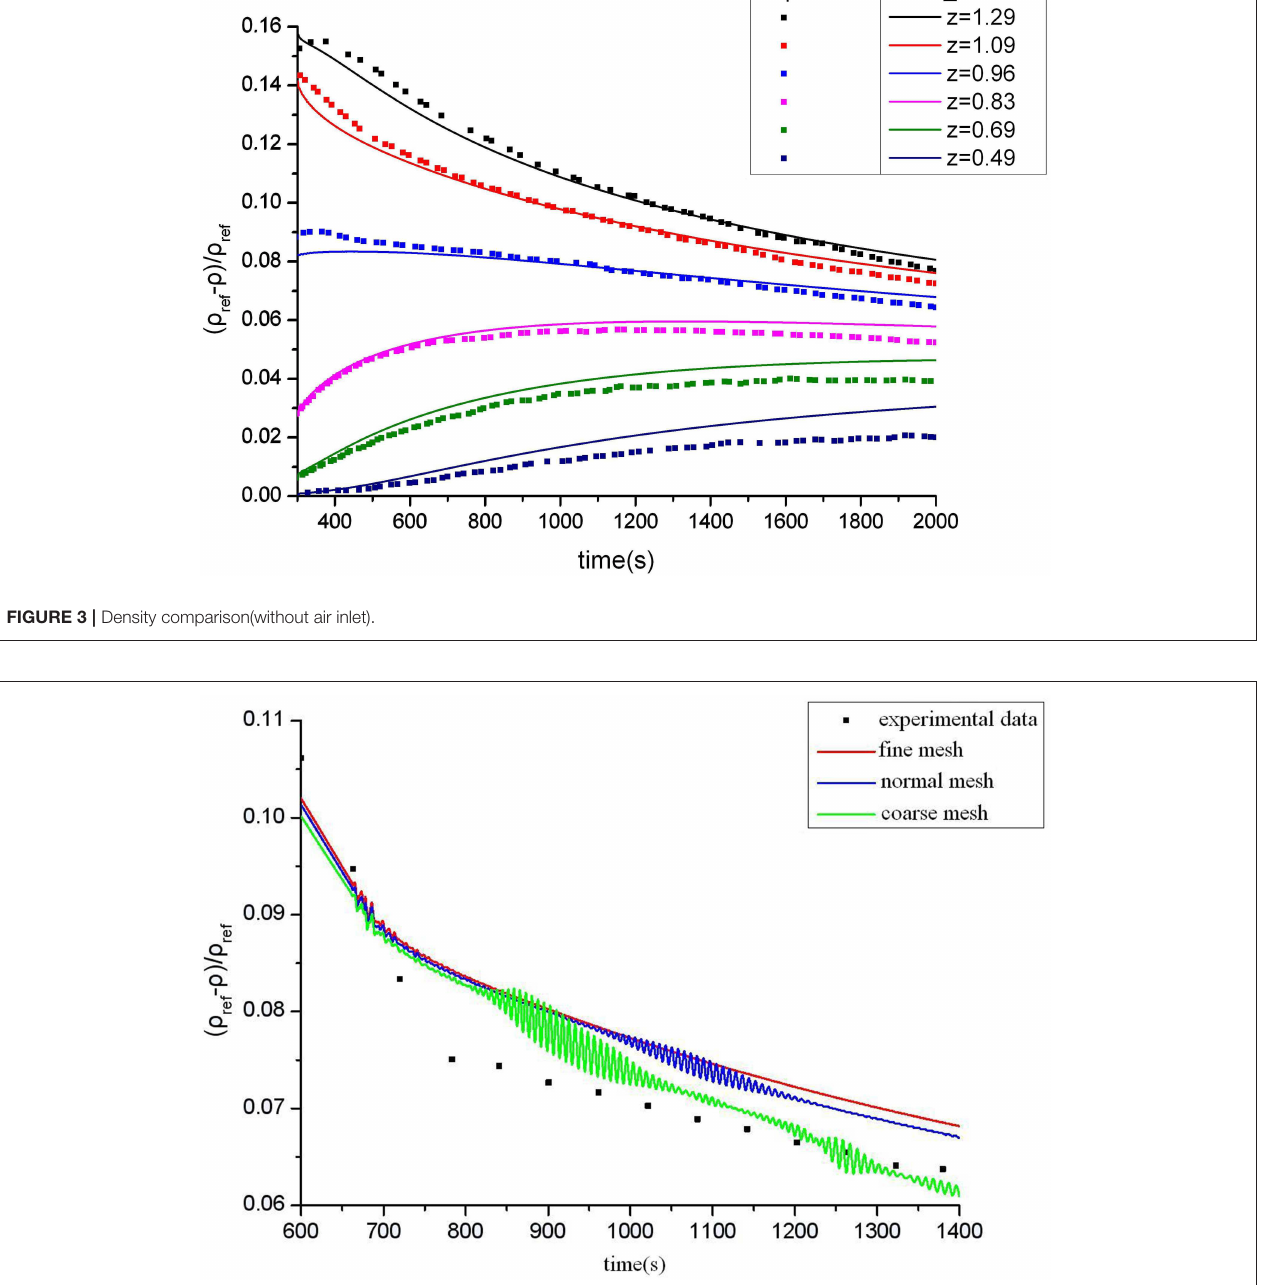
FIGURE 4 | Density comparison of different mesh size (Fr =